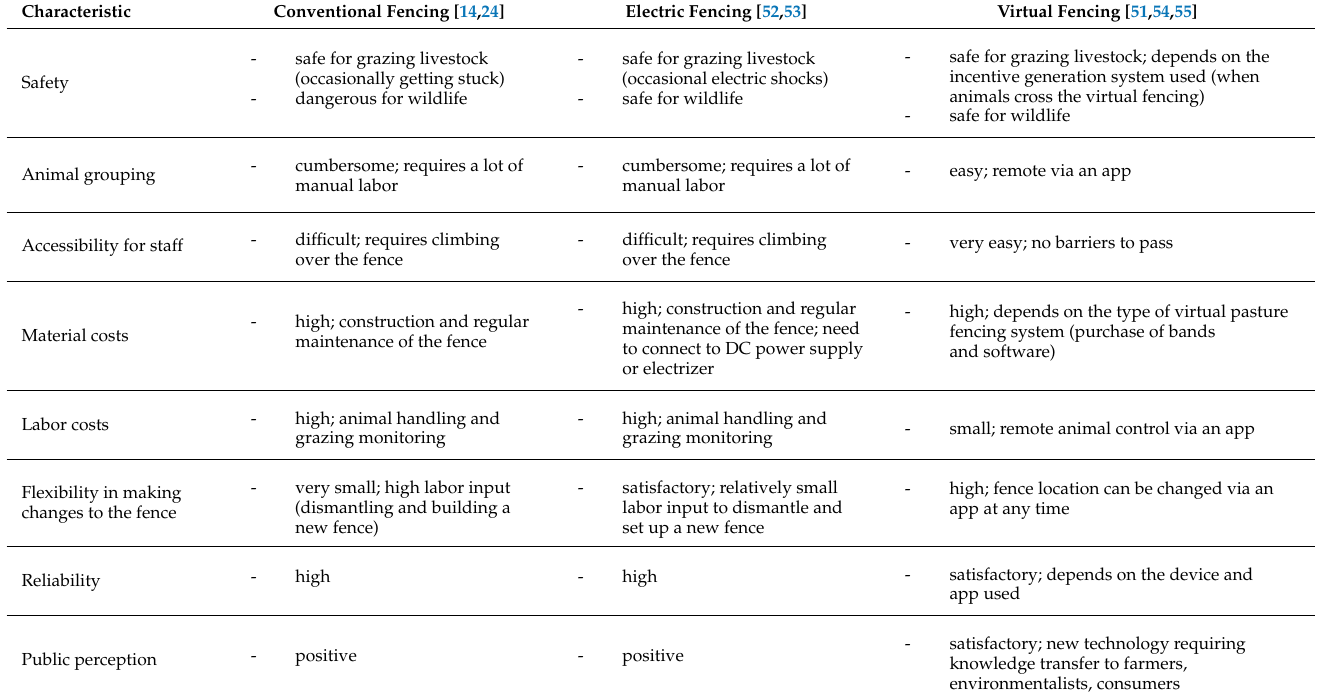
Table 1. Comparison of methods of pasture fencing and allocation of paddocks in terms of selected characteristics of animal pasture feeding.